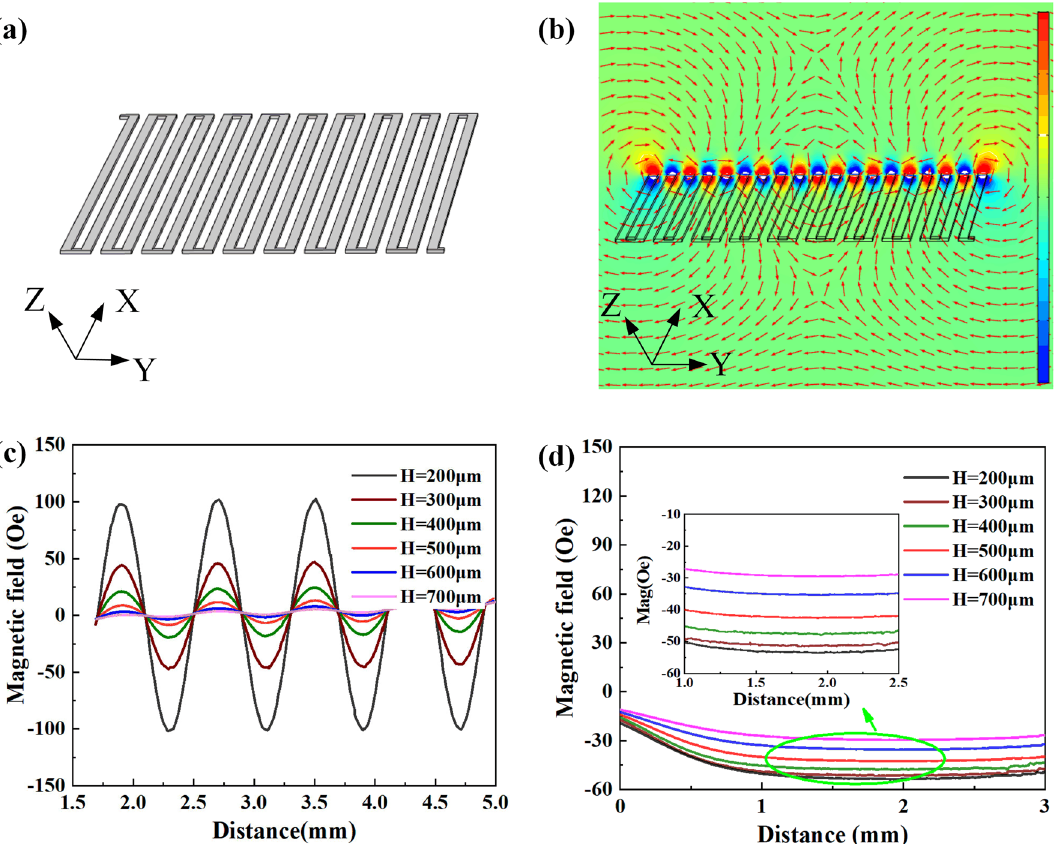
Figure 2. Magnetic field distribution analysis. H is the distance between electronic coil layer and TMR devices layer, ranging from 200 to 700 µ m with a step of 100 µ m . ( a ) Model of the electronic coil (Created by Microsoft Visio 2013 (15.0) and SOLIDWORKS(R) Premium 2016.). ( b ) The magnetic field distribution along the sense direction. ( c ) The magnetic field along the sense direction (Y-axis) versus different layer distance H . ( d ) The magnetic field along the X-axis versus different layer height H